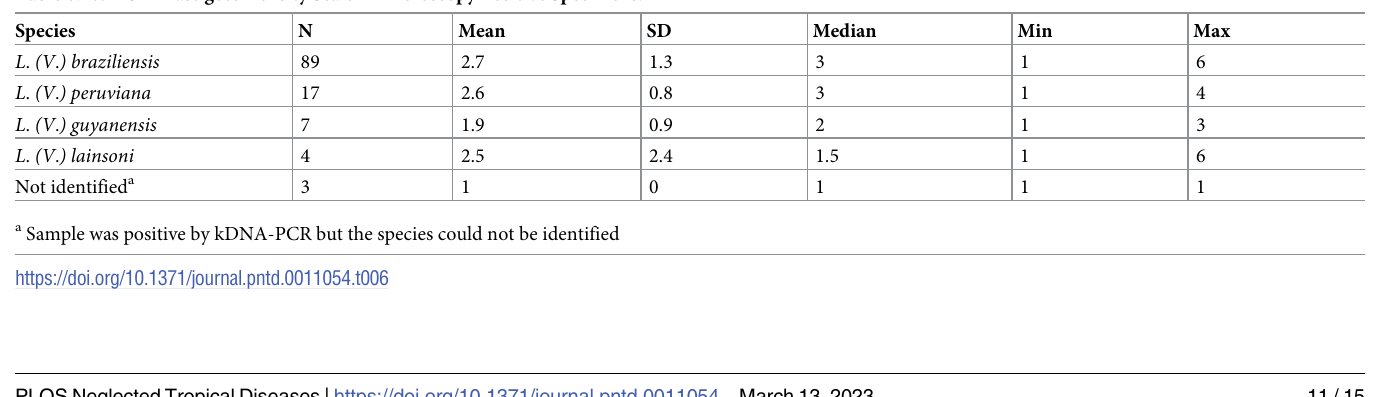
Table 6. WHO Amastigote Density Scale in Microscopy Positive Specimens. Species N Mean